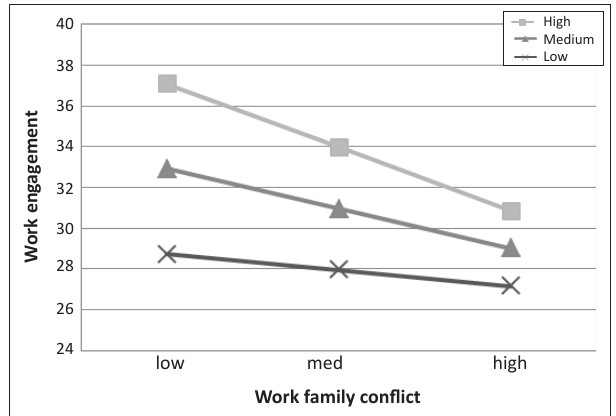
FIGURE 2: Regression analysis of the effect of work-family conflict on work engagement at three levels of